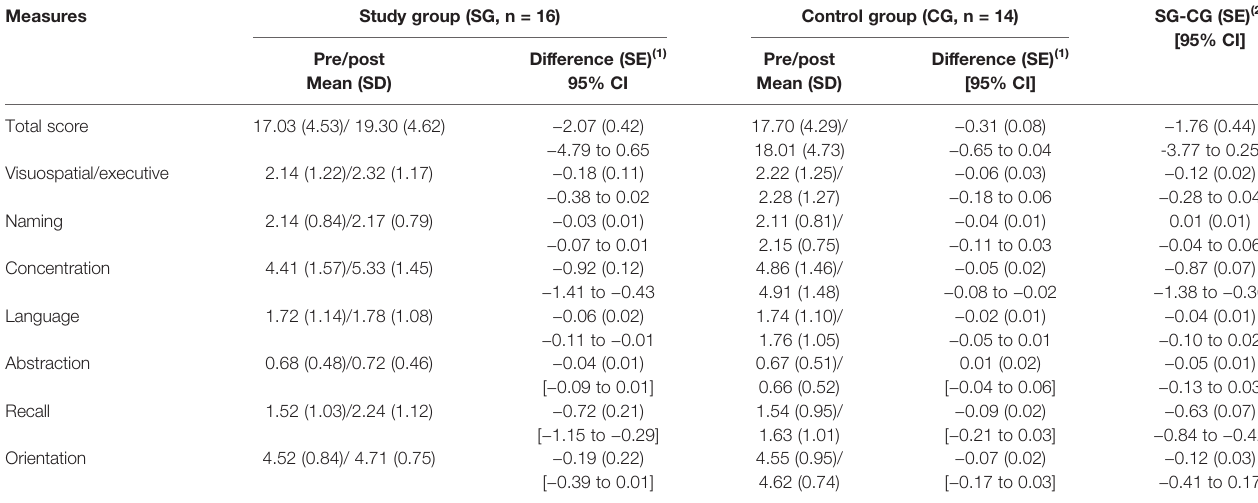
TABLE 2 | Comparison of cognitive scores between the two groups.